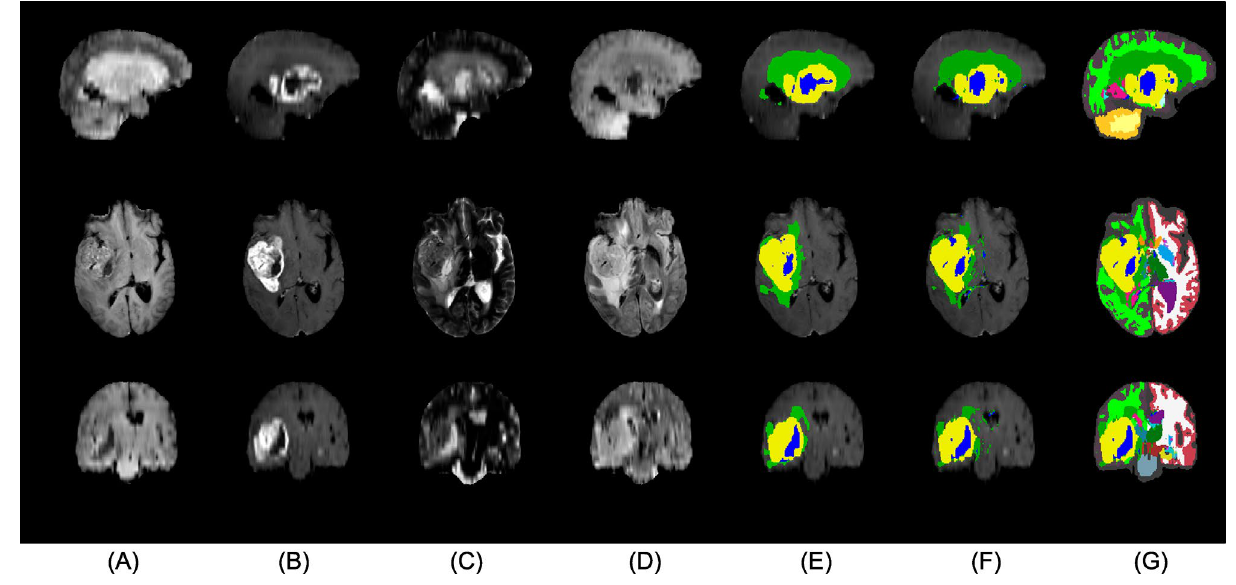
Figure 5. A sample from the BraTS20 (pre-operative) dataset. From top to bottom: sagittal, axial, and coronal view. The columns show ( A ) T1, ( B ) T1c, ( C ) T2, ( D ) FLAIR, ( E ) manual segmentation of tumor, and ( F , G ) the automatic segmentation output. ( F ) Shows the tumor components only, while ( G ) shows the full segmentation output. Some major differences to the Copenhagen (post-operative) dataset (see Fig. 4) can be seen in this